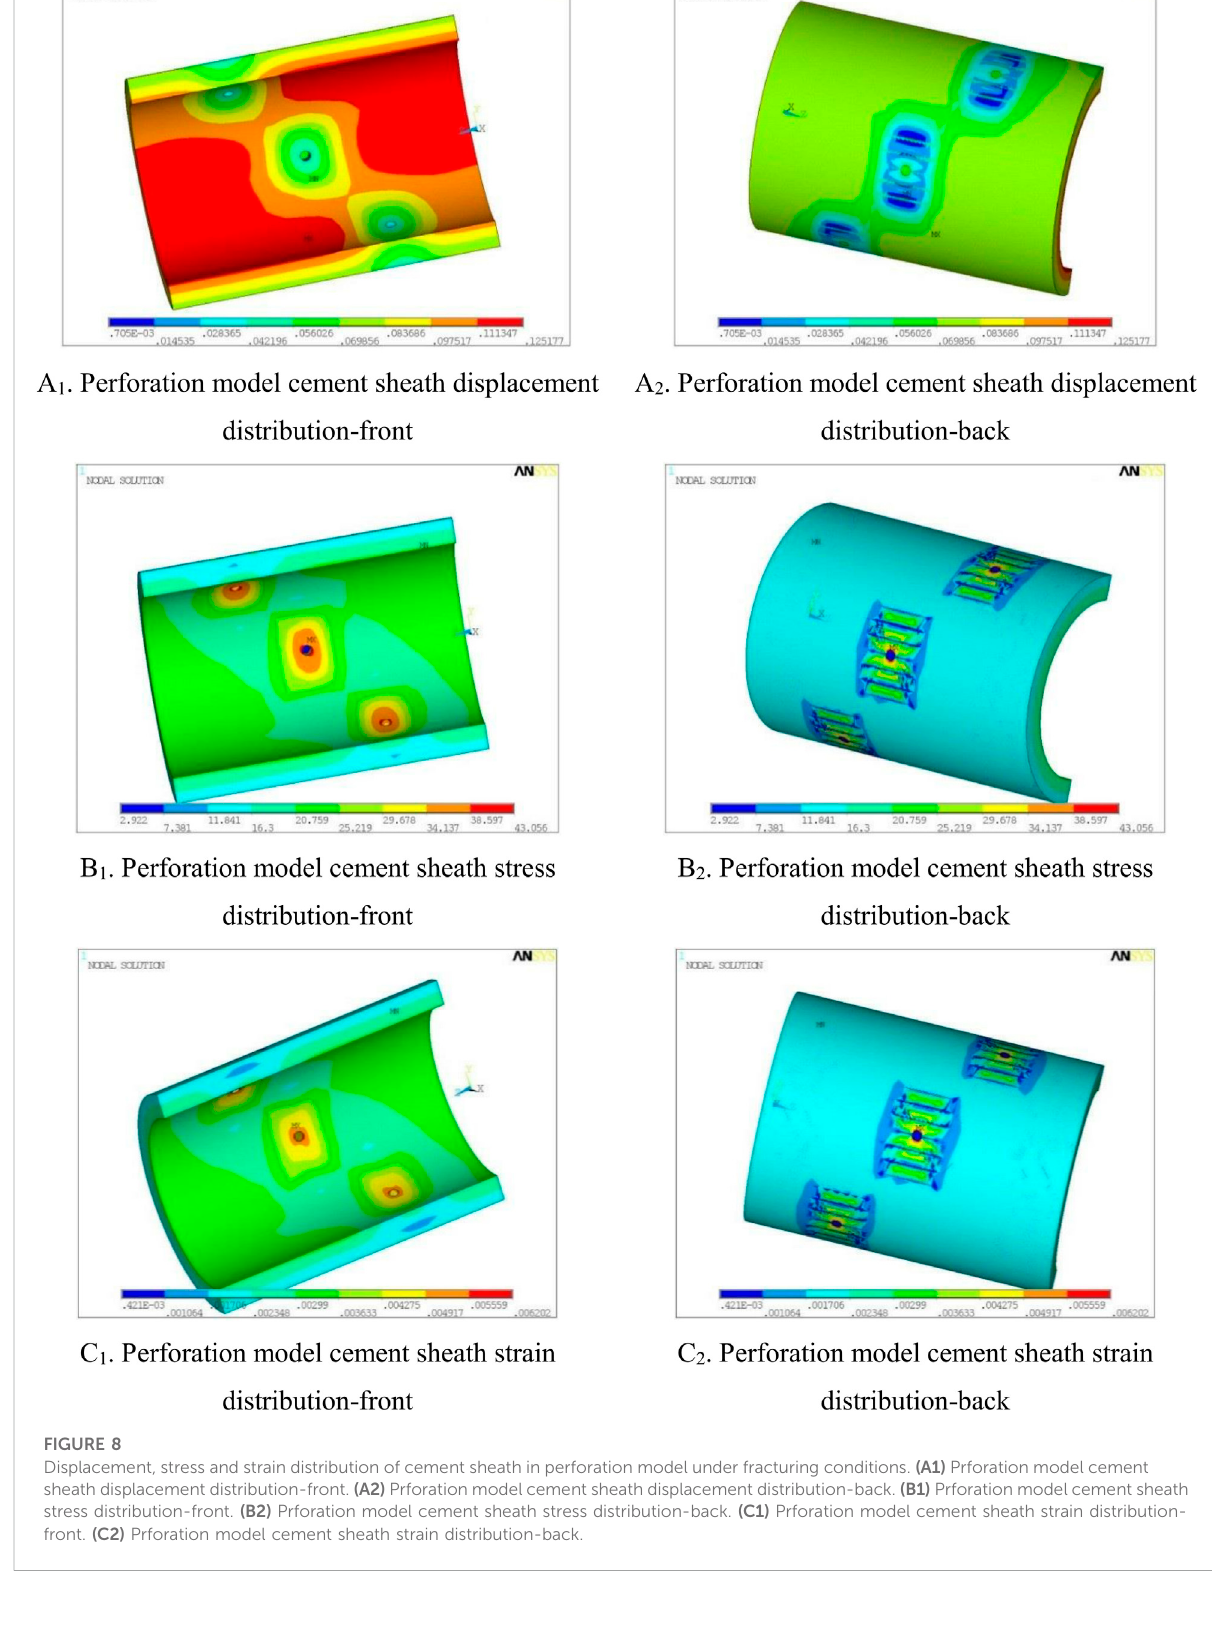
FIGURE 8 Displacement, stress and strain distribution of cement sheath in perforation model under fracturing conditions. (A1) Prforation model cement sheath displacement distribution-front. (A2) Prforation model cement sheath displacement distribution-back. (B1) Prforation model cement sheath stress distribution-front. (B2) Prforation model cement sheath stress distribution-back. (C1) Prforation model cement sheath strain distribution- front. (C2) Prforation model cement sheath strain